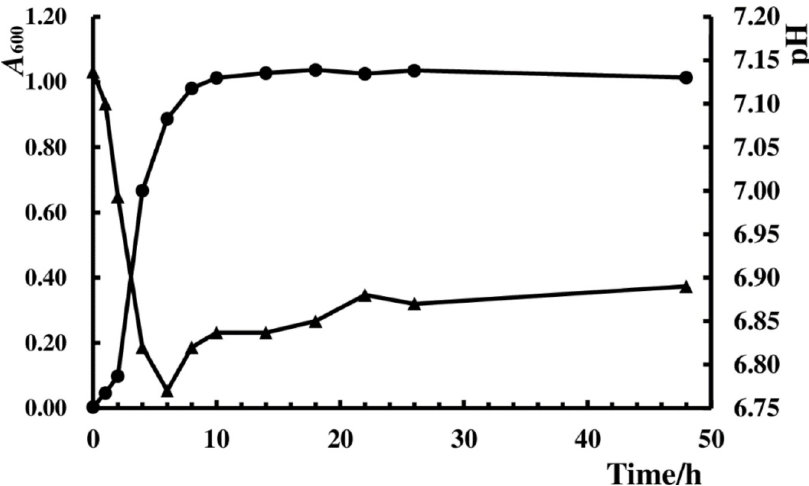
Fig 6. Growth curve and variation of pH value of strain HXBM408 in BHI-daidzein